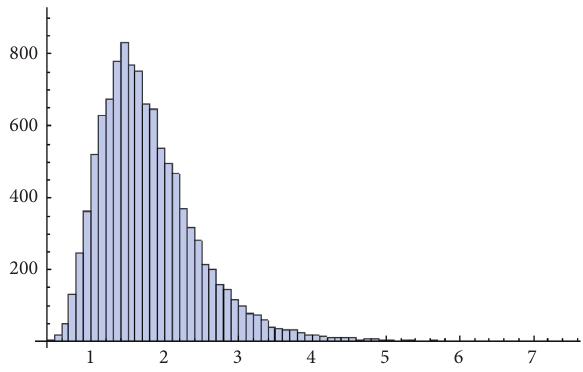
Figure 4: The histogram of θ